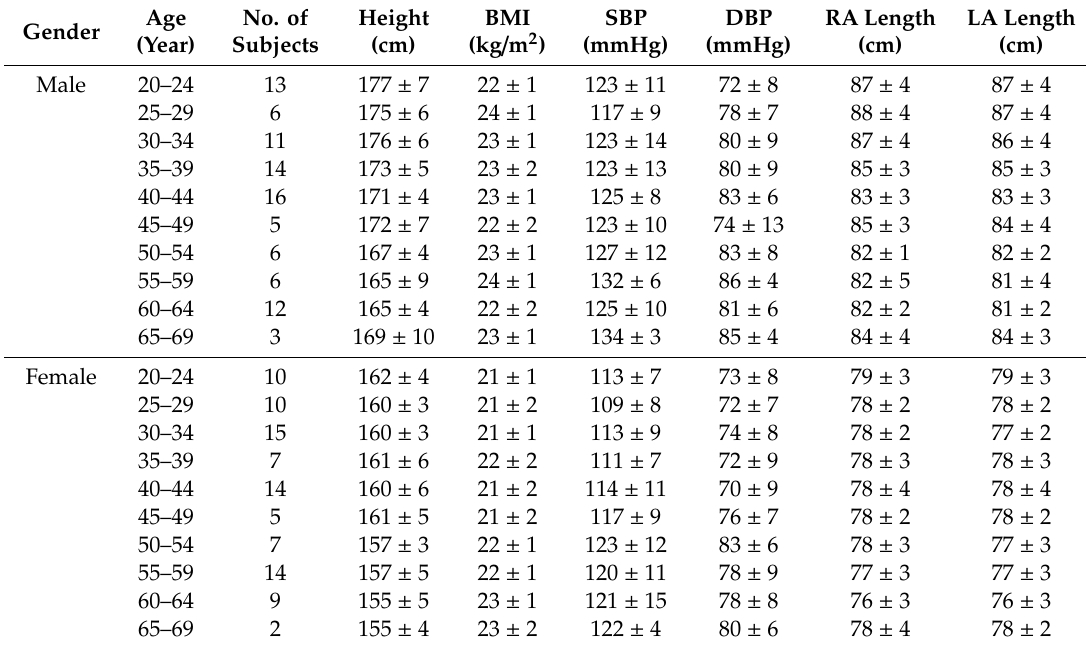
Table 2. Anthropometrics of subjects (n = 185) in chronological classification (RA: right arm, LA: left arm).